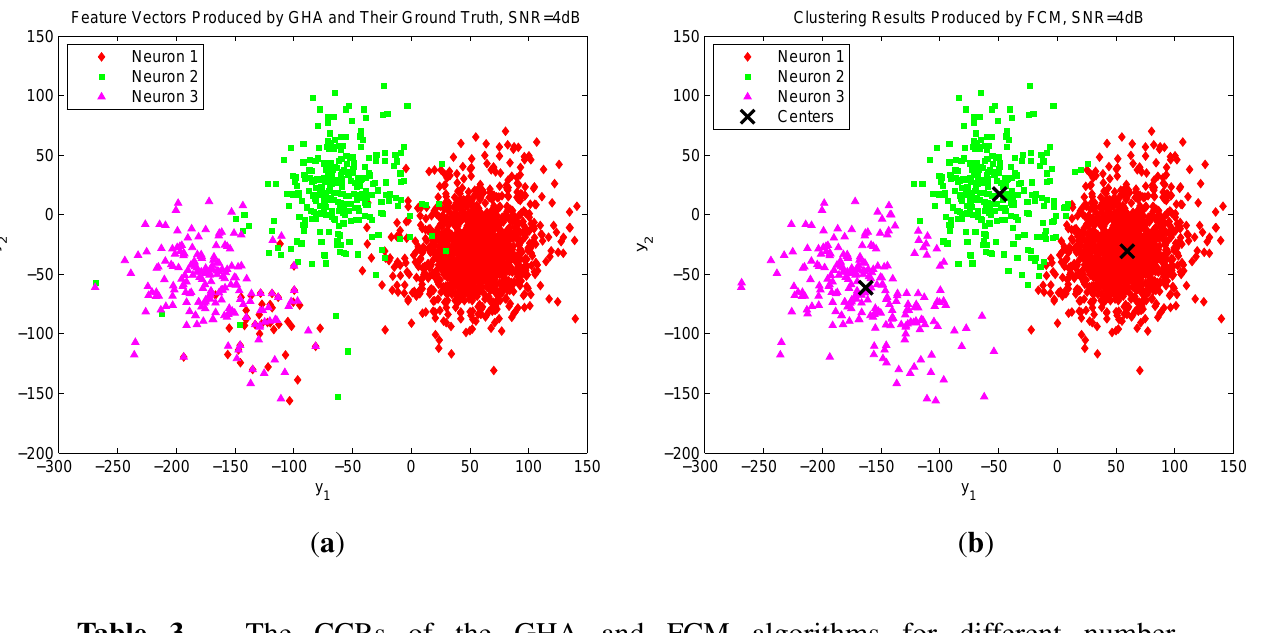
Figure 13. The distribution of GHA feature vectors of spikes, and the results of FCM clustering for SNR = 10. ( a ) Ground truth of neuron spikes; ( b ) clustering results produced by FCM.